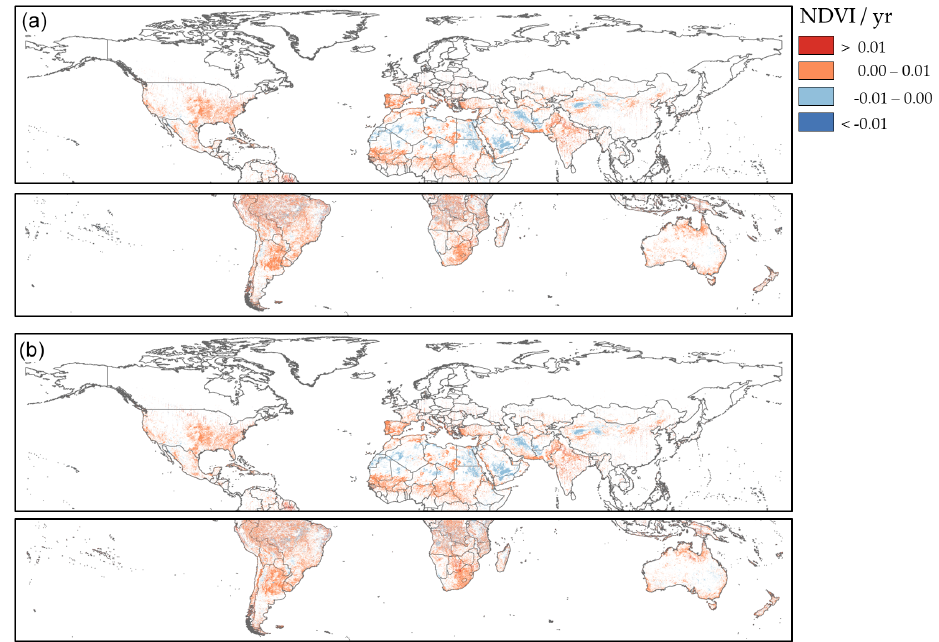
Figure 8. The change in maximum normalized difference vegetation index (NDVI) per year (yr) from the (a) Global Inventory Modeling and Mapping Studies (GIMMS) and (b) Vegetation Index and Phenology Lab (VIP) records. The upper panals represent the Northern Hemisphere (30-year change) and the lower panels represent the Southern Hemisphere (29-year change). The trends have been masked for significance ≤ 0.05.